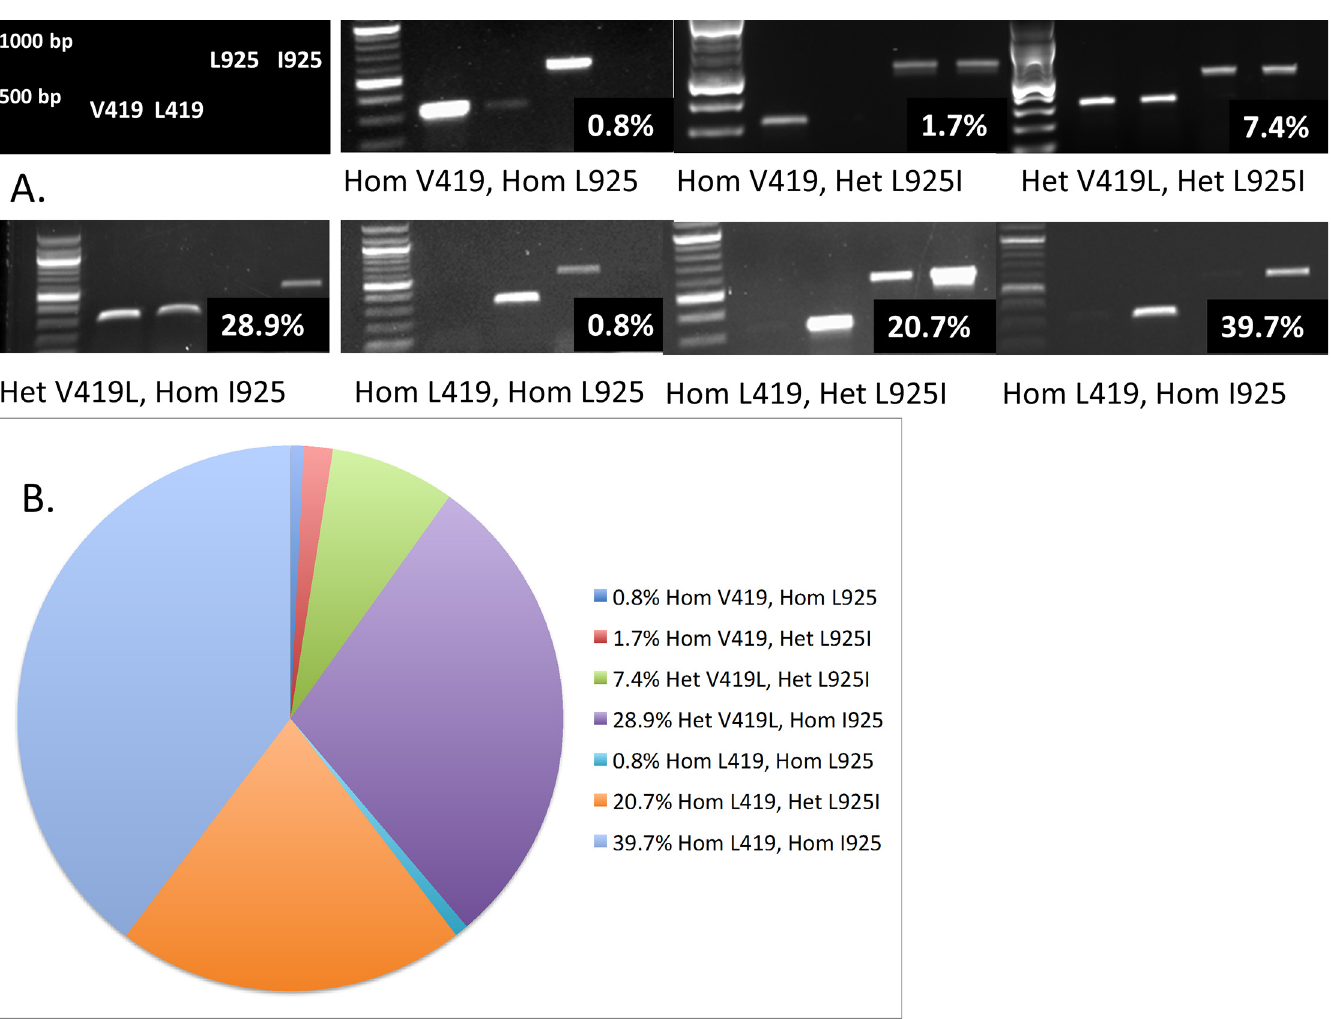
Fig 2. kdr Diploid genotypes following PCR amplification of apartment samples. (A) The frequency of each genotype is presented in the bottom right corner of each gel image. The two brightest bands in the molecular weight ladder denote 500 and 1000 basepairs. “ Hom ” denotes homozygous, and “ Het ” denotes heterozygous. Two genotypes – Hom V419/Hom I925 and Het V419L/Hom L925 – were not represented in any of the collections and are therefore not shown. (B) Frequency of 419 or 925 susceptible (V419/L925) or kdr mutant (L419/I925) alleles from bed bugs collected in an apartment